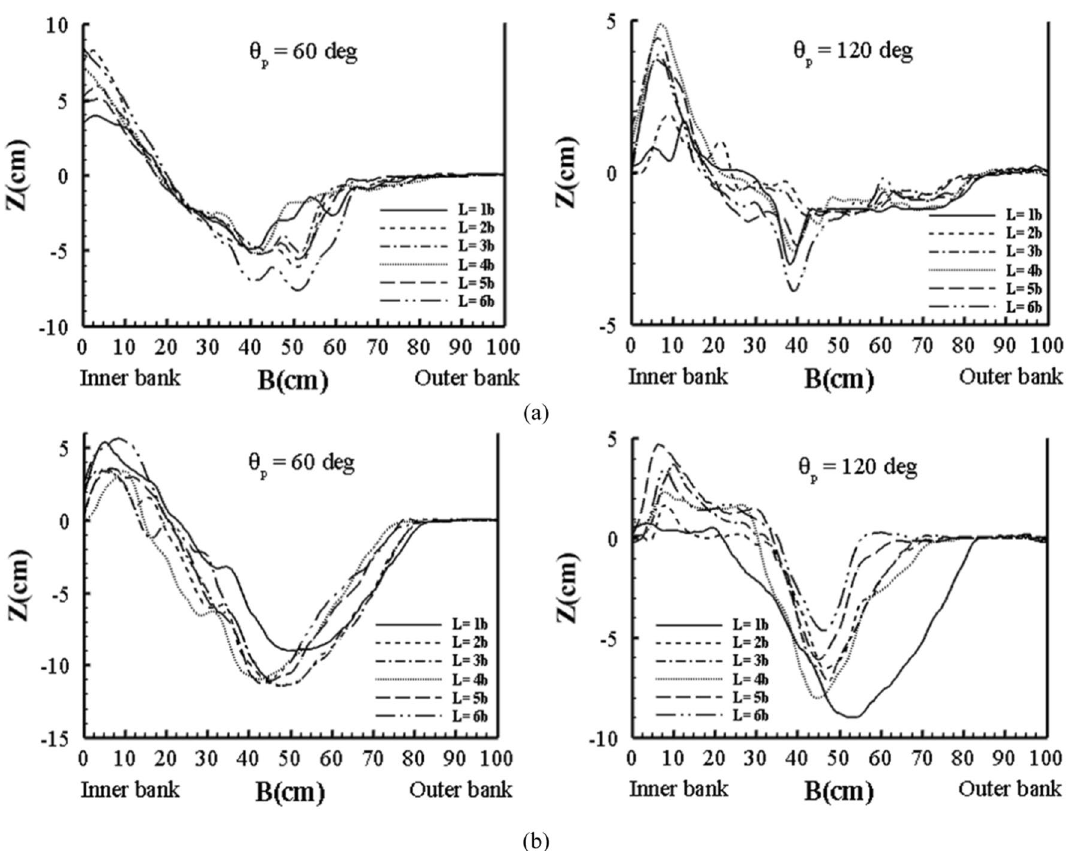
Fig. 12 A sample of transverse sections surrounding the piers and collar combination a near the piers nose and b at the location of the second scour cavity maximum depth